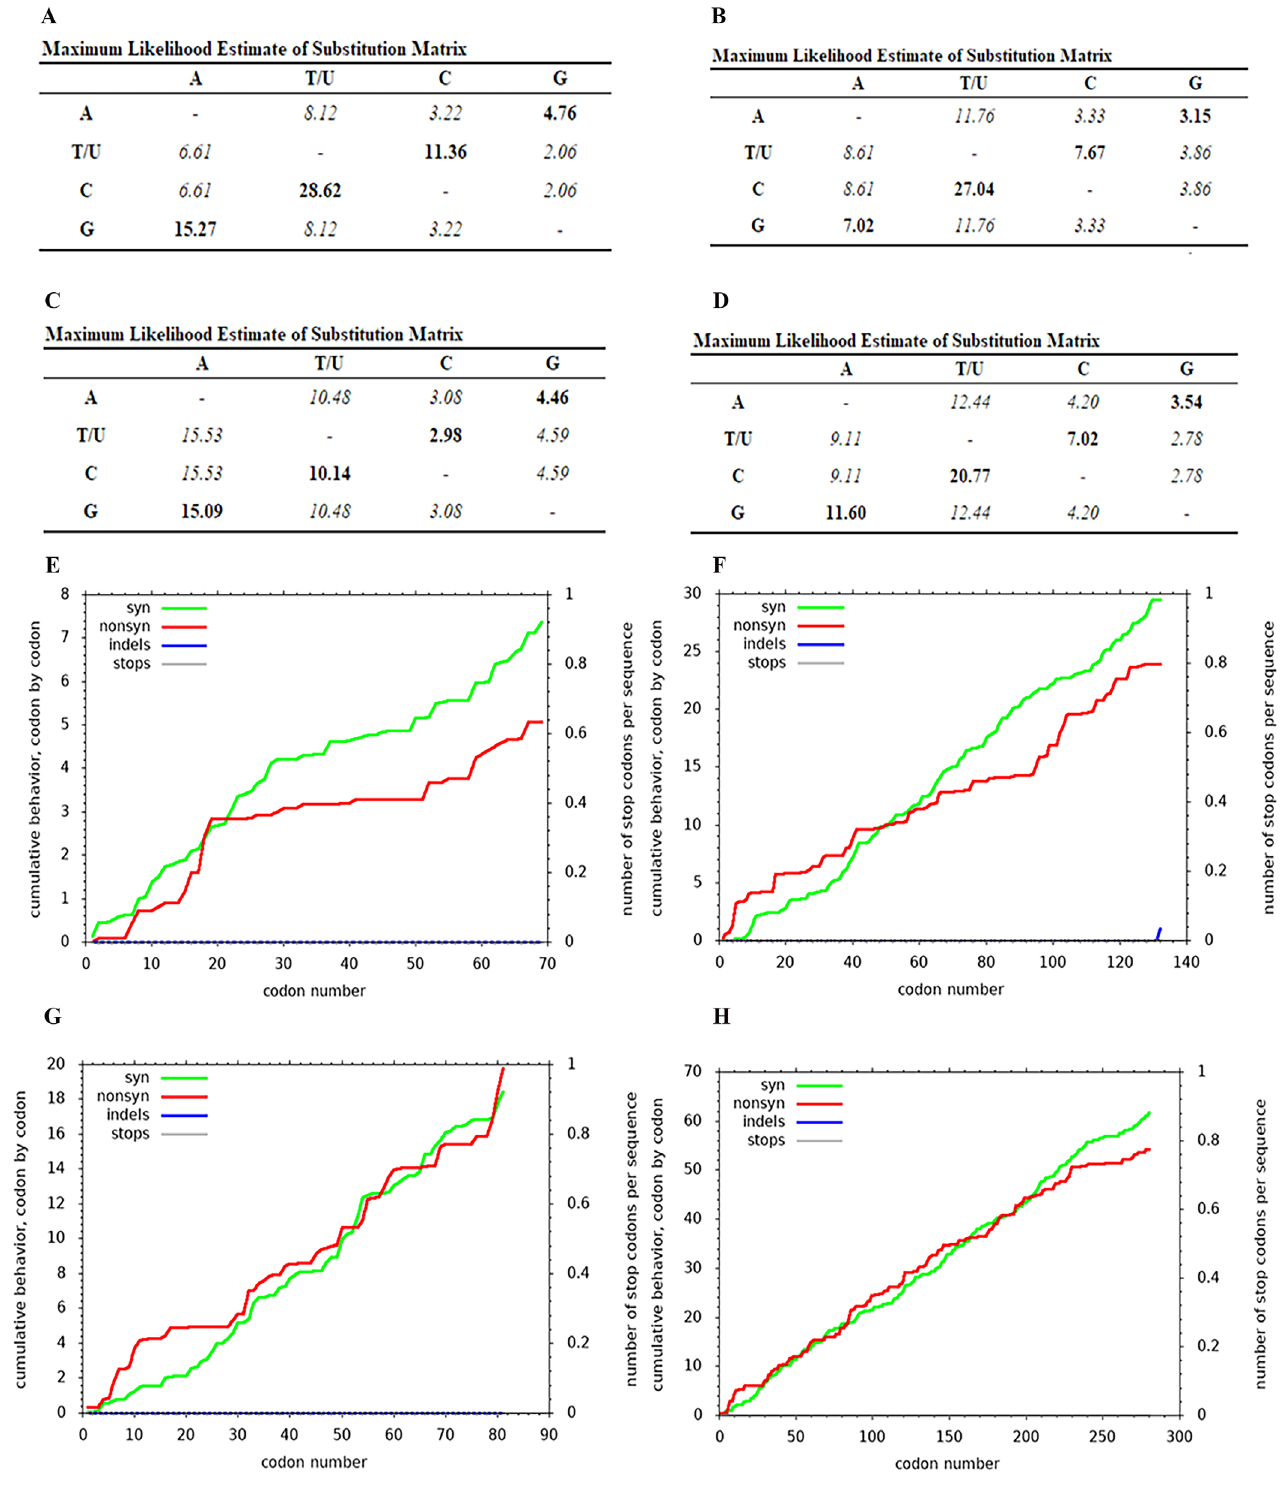
Fig. 6. Nucleic acid substitution rate and base composition of cytb, coxI, coxIII and concatenated sequences among Leucocytozoon spp. and Plasmodium spp. Tables showing the transition and transversion from nucleotide substitution in cytb (A), coxI (B.), coxIII (C) and concatenated (D) genes. Graph incidating the synonymous and non-synonymous substitutions of cytb (E), coxI (F), coxIII (G) and concatenated (H) genes of Leucocytozoon spp. and Plasmodium